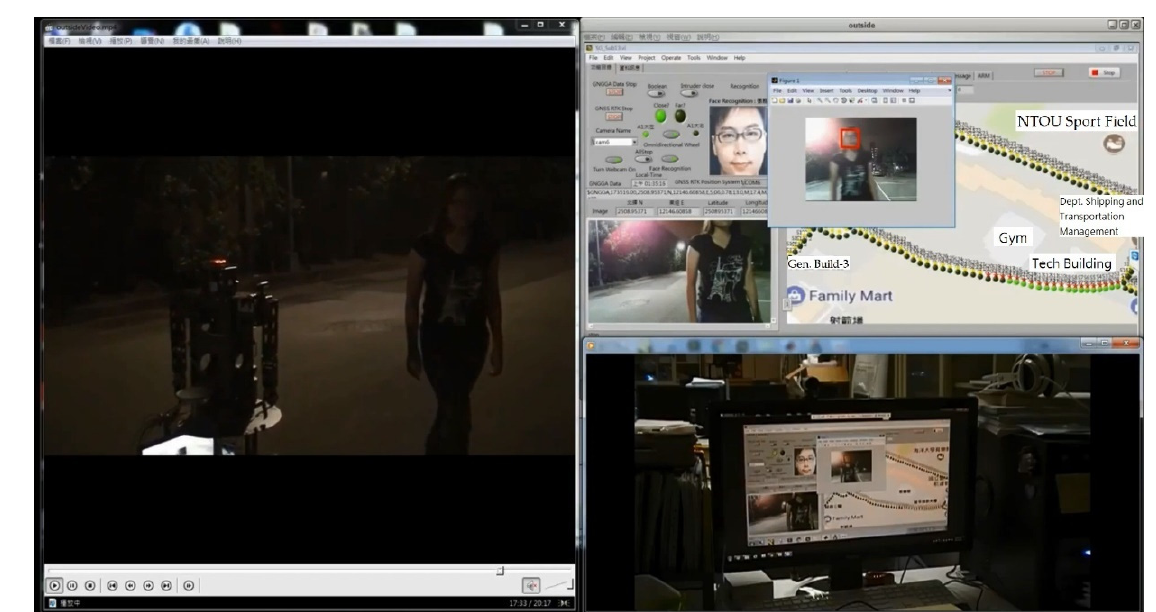
Figure 35. The robot patrolled in the nighttime and encountered a stranger passing by.